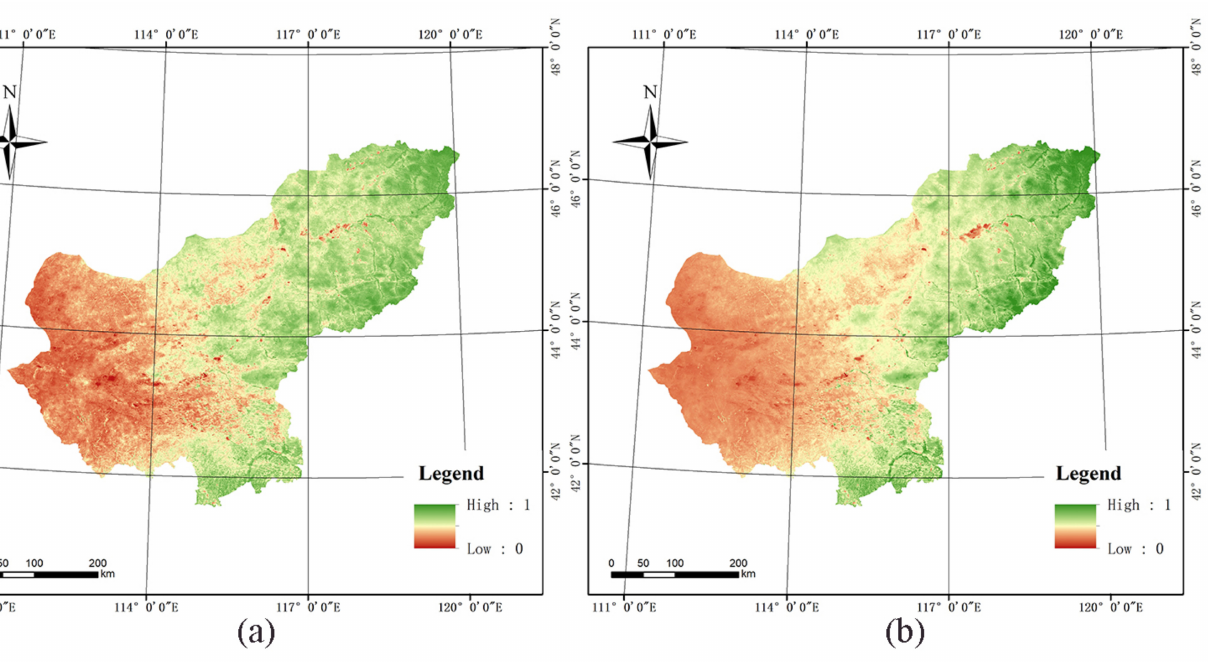
Figure 2. Spatial distribution of the NDVI in the Xilin Gol League: ( a ) maximum value composite (MVC) and ( b )